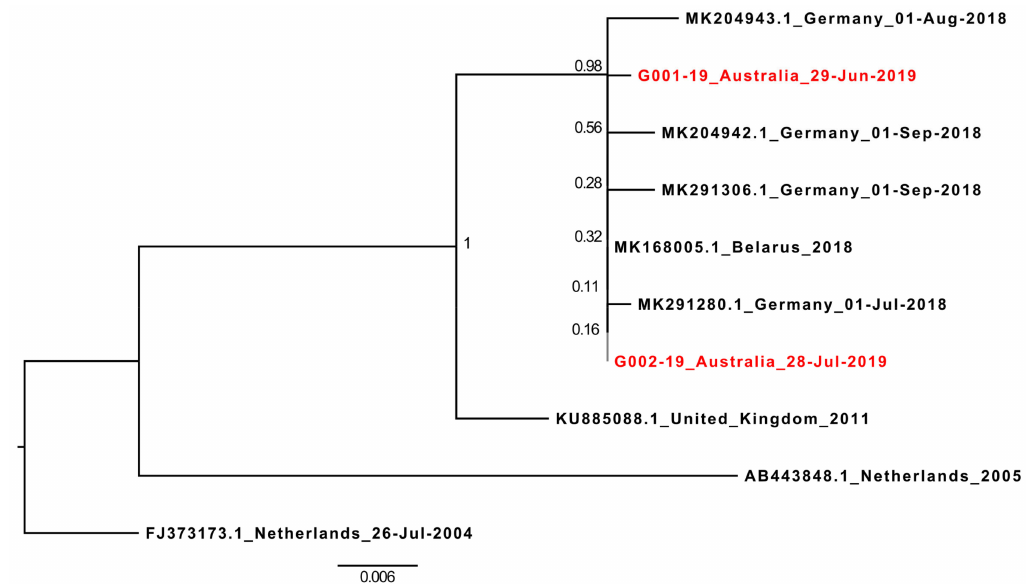
Figure 2. Maximum-likelihood tree of 567nt of all HPeV5 VP1 sequences from the NCBI GenBank with > 90% similarity to G001-19. The tree was generated in Mega X using the GTR + G + I model. Branch support was determined with 1000 bootstrap replicates, and is shown at each node. The near full-length 2019 recombinant HPeV5 sequences described here are in